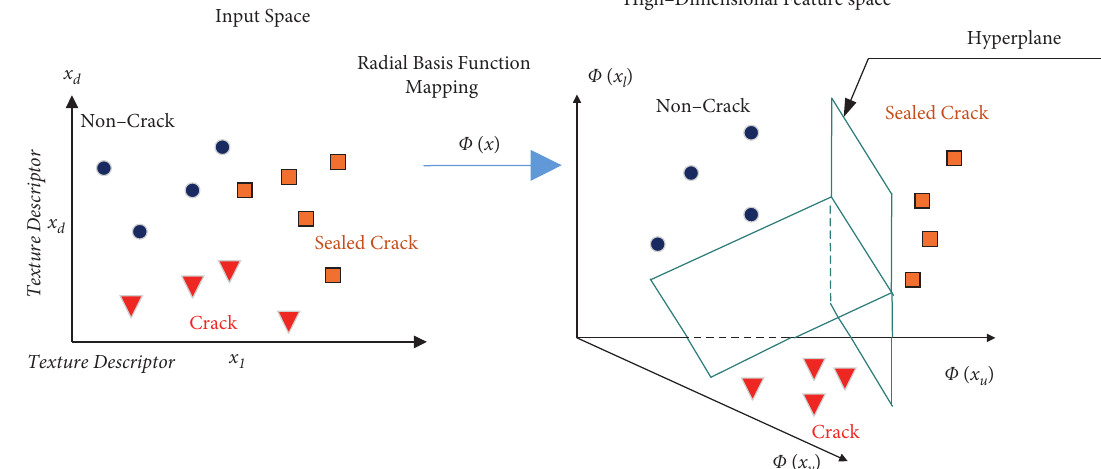
Figure 6: Demonstration of the SVM classifier used for recognizing crack and sealed